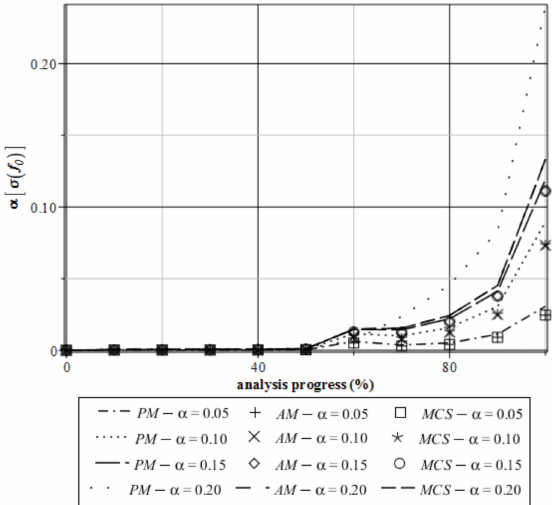
Figure 12. Coefficient of variation of the extreme von Mises stress α [ σ (f 0 )] for the